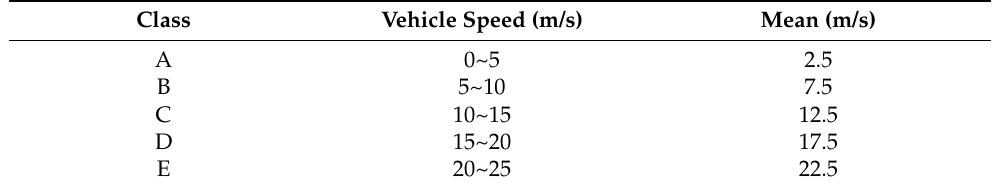
Table 4. Classification of vehicle